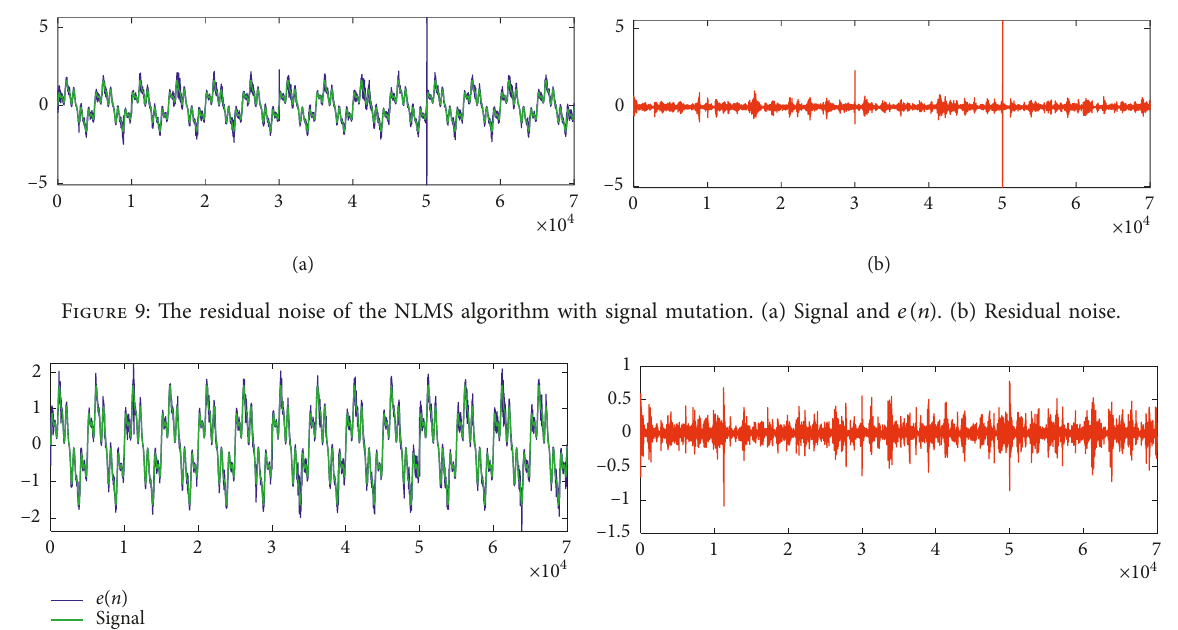
Figure 10: The residual noise of the improved LMS algorithm with signal mutation. (a) Signal and e